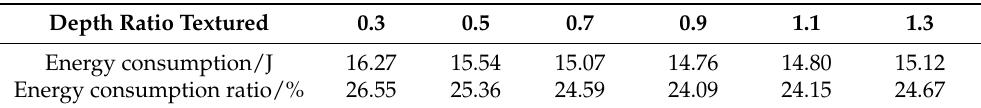
Table 2. Energy consumption and its ratio in one cycle with different depth ratio textured when area ratio textured is 0.3.